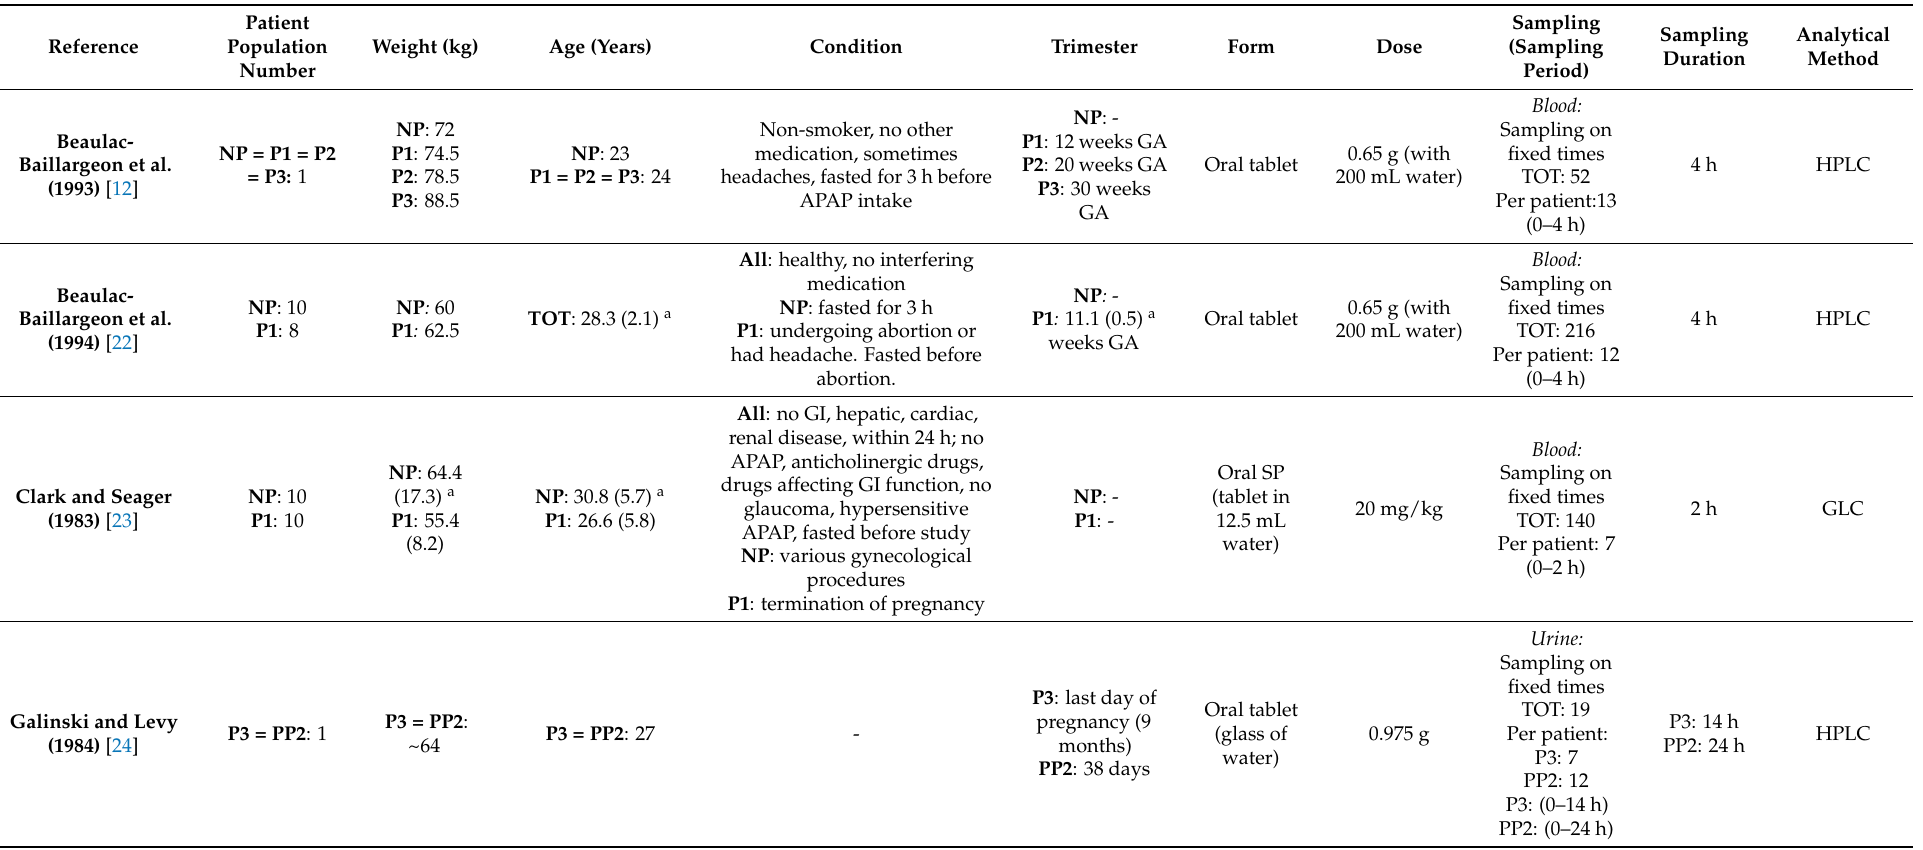
Table 1. Overview of characteristics of included PK studies, obtained with NCA. Studies are presented in alphabetical order by author. Data shown as median [range] or mean (SD) otherwise if specified.